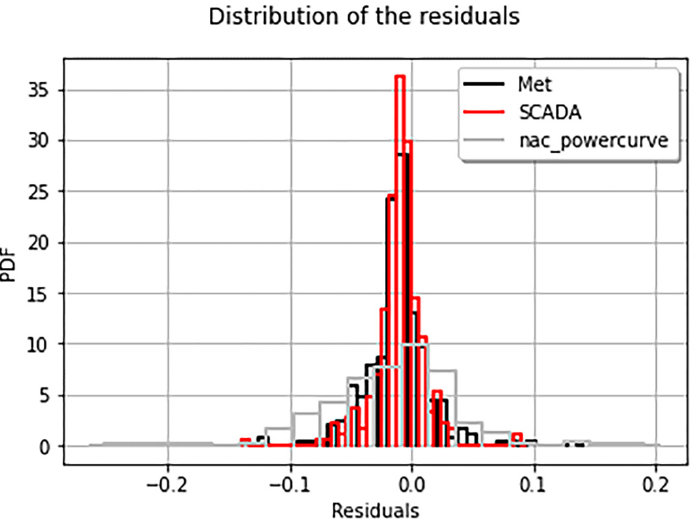
Figure 15. Frequency statistics of residuals between predicted and measured values of the three models.